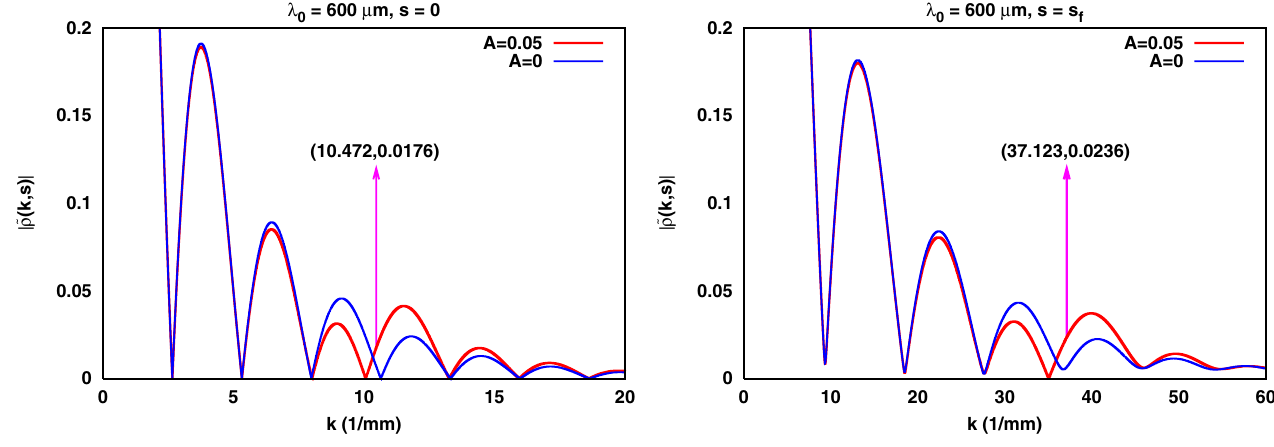
¼ 600 (cid:4) m with and without perturbation at s ¼ 0 (left) and s ¼ s 0